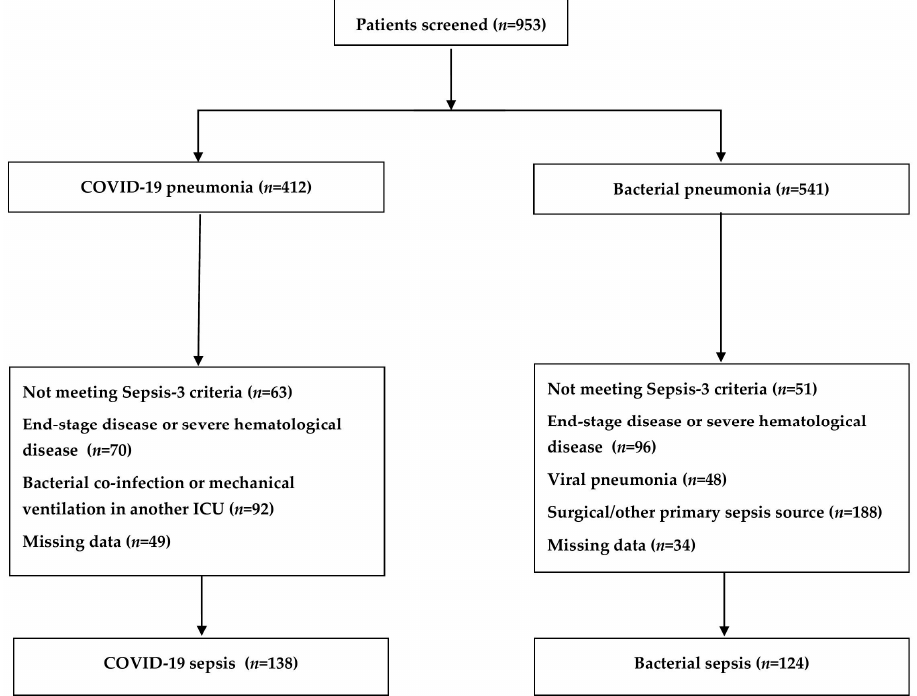
Figure 1. Flowchart of the study population. Lower P/F ratio values were observed in patients with COVID-19 sepsis ( p < 0.001), but mechanical ventilation need was similar between groups (74.6% vs. 71.8%, p = 0.601). On the other hand, vasopressor support was needed more often in bacterial sepsis ( p < 0.001), patients from this group having higher SOFA score values ( p < 0.001) (Table 1). Lastly, among patients with bacterial sepsis, pneumonia was clasiffied as following: 60 (48.4%) presented with community-acquired pneumonia, 34 (27.4%) had healthcare-associated pneumonia and 30 (24.2%) had hospital-acquired